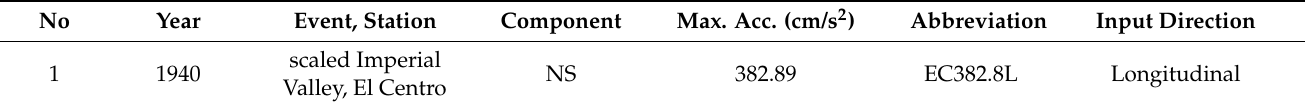
Figure 6. Time history acceleration of input motion. Table 2. Detail of input motion